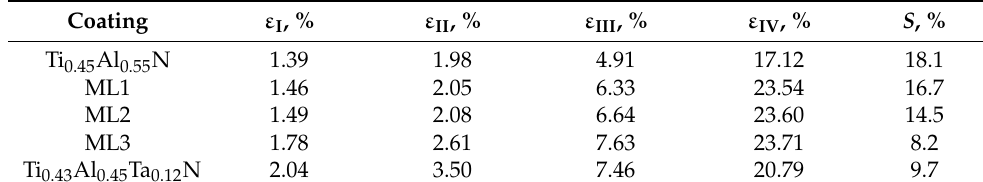
Table 2. Substrate elongations corresponding to the onset of different failure stages of the coatings and the relative area of coating spallation after fracture of the substrates.